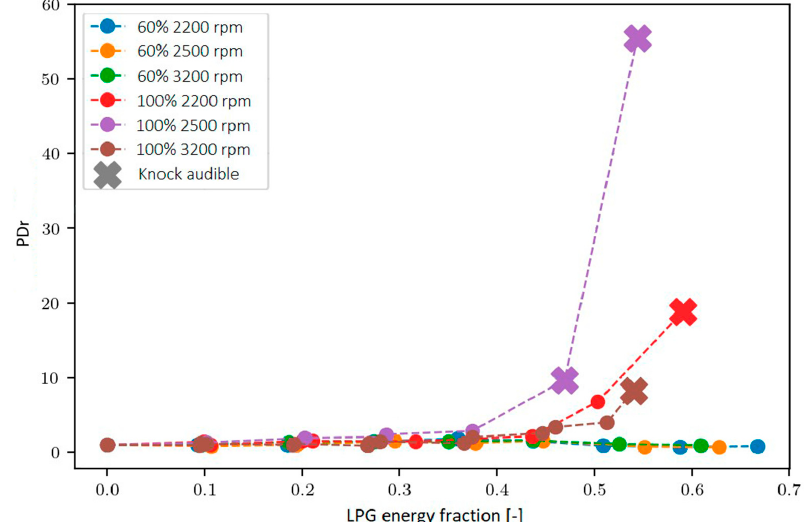
Figure 3. PDr vs. LPG energy fraction at different engine loads and speeds.